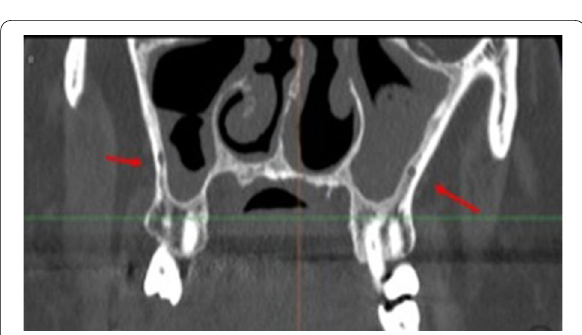
Fig. 5 Left: Intrasinus (I) PSAA. Right: intraosseous (II)